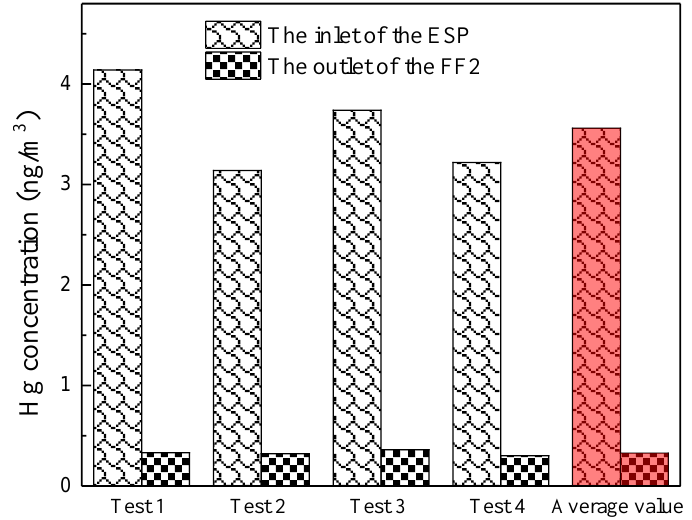
Figure 6. Hg concentration in the flue gas at the inlet of the ESP and the outlet of the FF2.